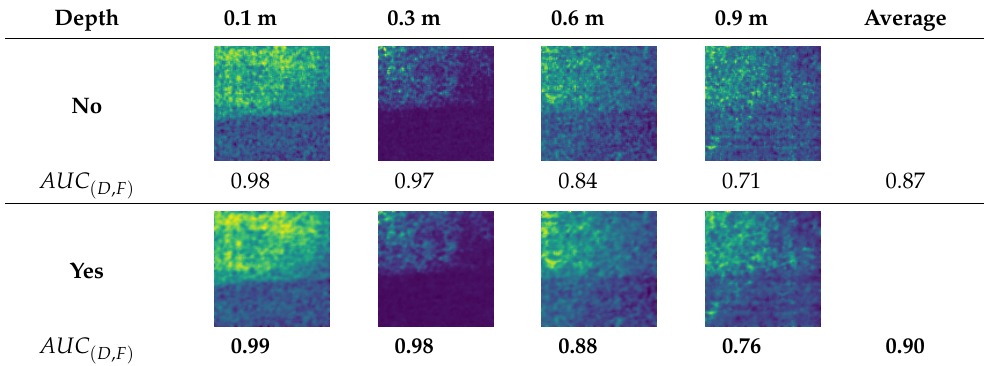
Table 14. The effect of the spatial–spectral process on the detection of rubber